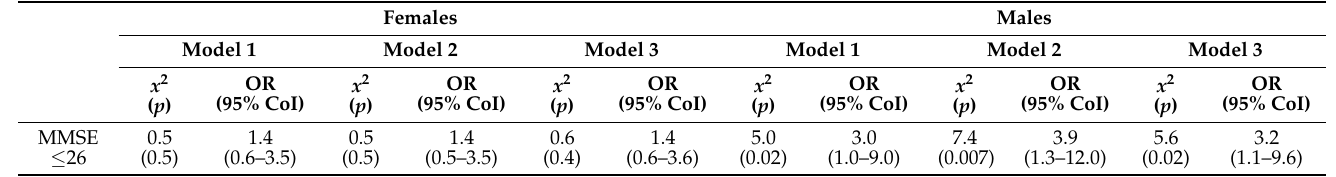
Table 11. Odds of MMSE scores indicative of MCI by KCNJ2 -A allele presence in models adjusting for diet quality, by sex.